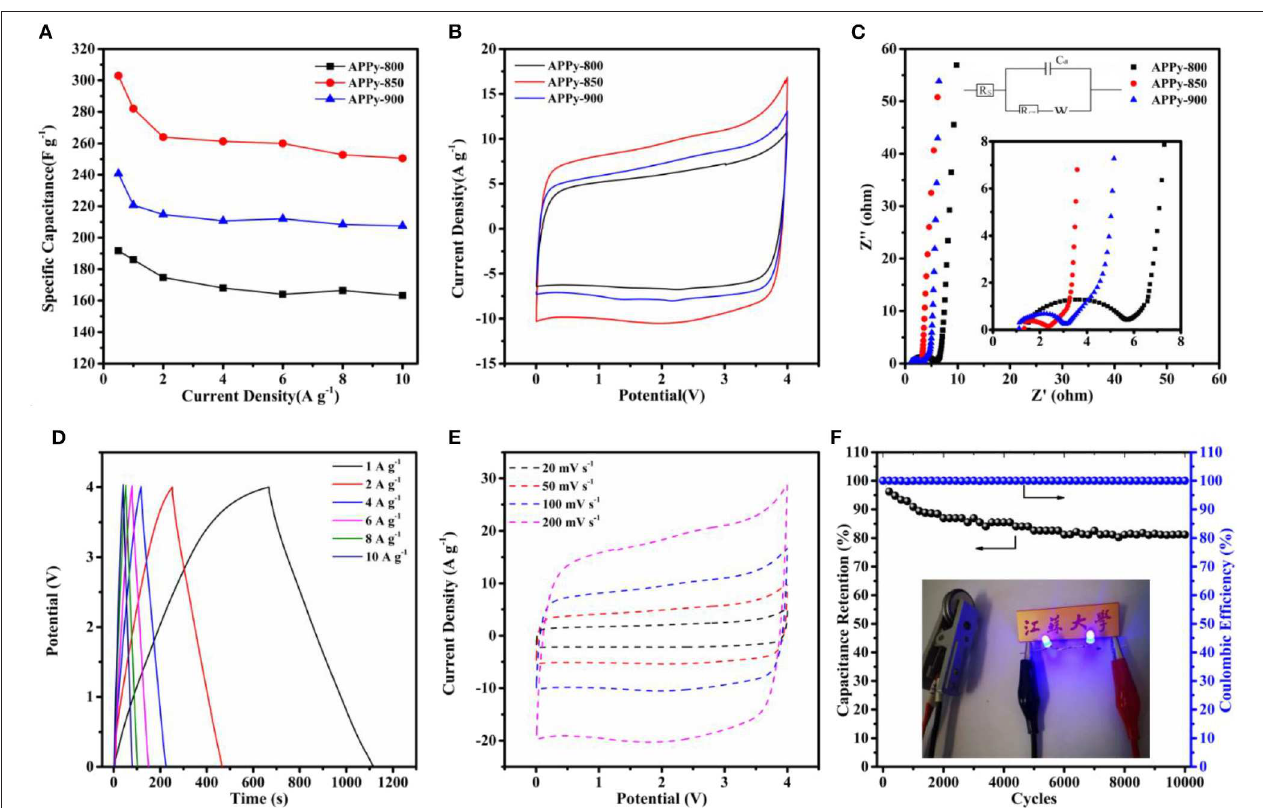
FIGURE 4 | (A) Rate capability: current density vs. specific capacitance. (B) Cyclic voltammetry (CV) curve of three samples at 100mv s − 1 . (C) Nyquist plots of three samples; the inset is a magnification of the high-frequency range data and fitting equivalent circuit. (D) Galvanostatic charge–discharge (GCD) curve of APPy-850-SC at current densities of 1, 2, 4, 6, 8, and 10A g − 1 . (E) CV curve of APPy-850-SC at a scan rate of 20–200mV s − 1 . (F) Cycling stability and coulombic efficiency of APPy-850-SC at 6A g − 1 for 10,000 cycles. The inset shows photographs of two blue